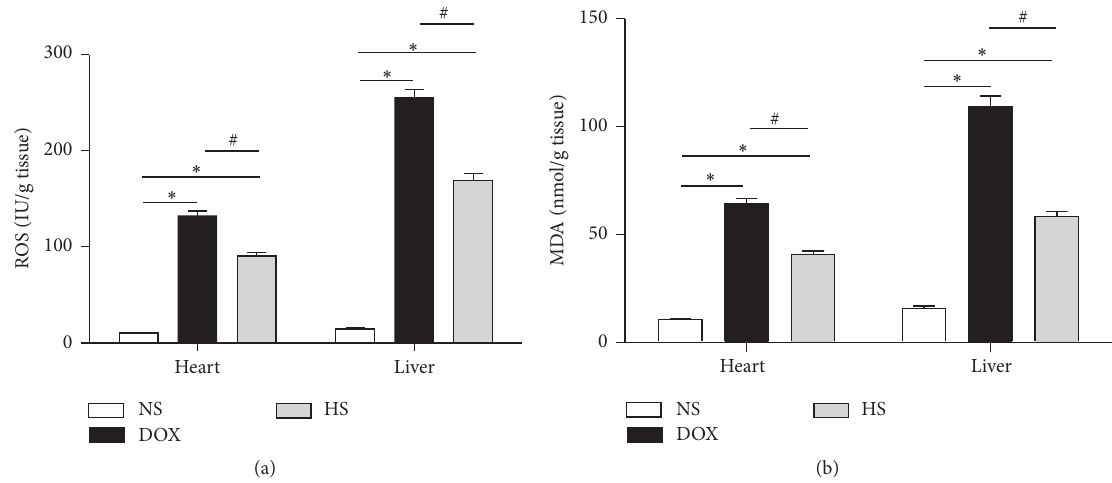
Figure 3: Effects of hydrogen-rich saline on ROS and MDA levels. The ROS (a) and MDA (b) levels of cardiac and hepatic tissues in three groups were detected. Data are shown as mean ± SD. ∗ 𝑃 < 0.05 versus NS group; # 𝑃 < 0.05 versus DOX